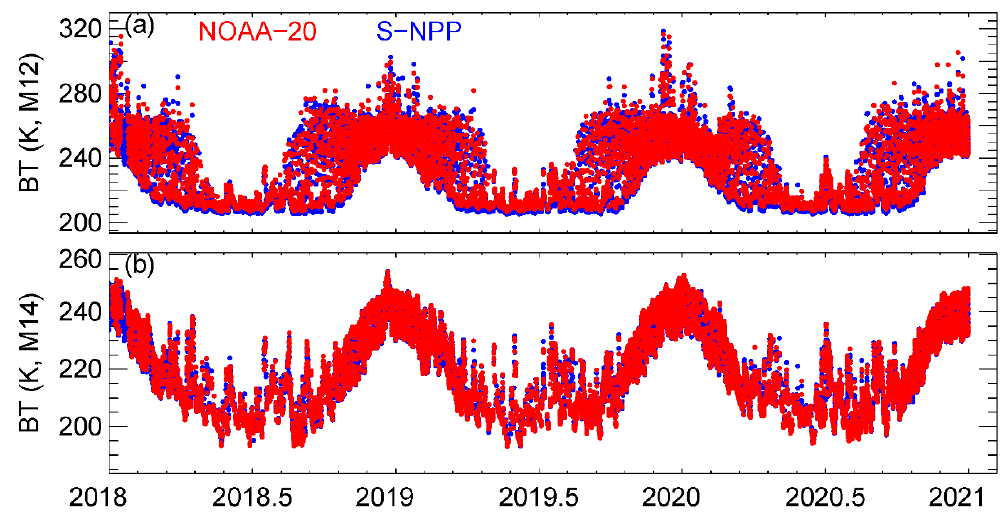
Figure 11. Comparison of NOAA-20 (red) and S-NPP (blue) bands M12 ( a ) and M14 ( b ) BTs over the Dome-C site.